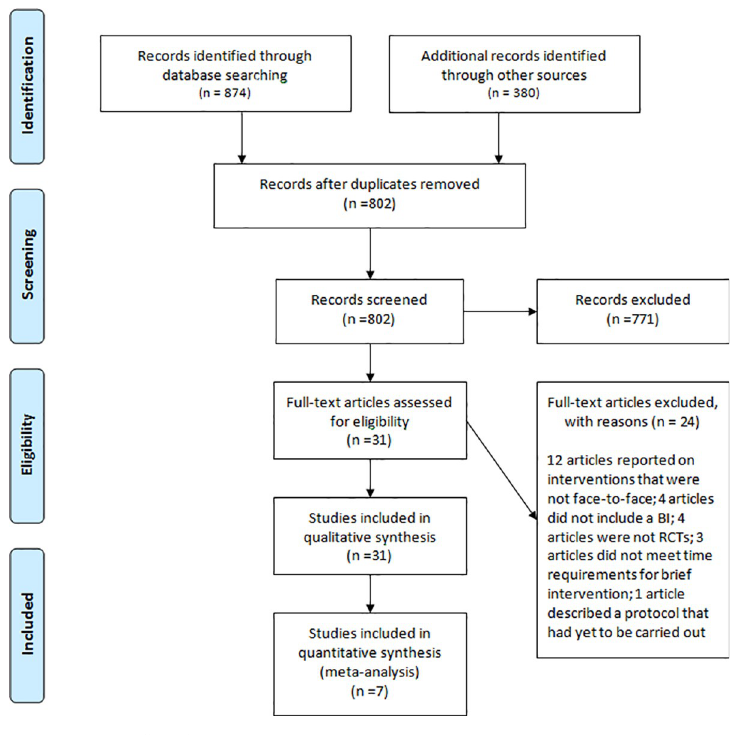
Fig 1. PRISMA flow